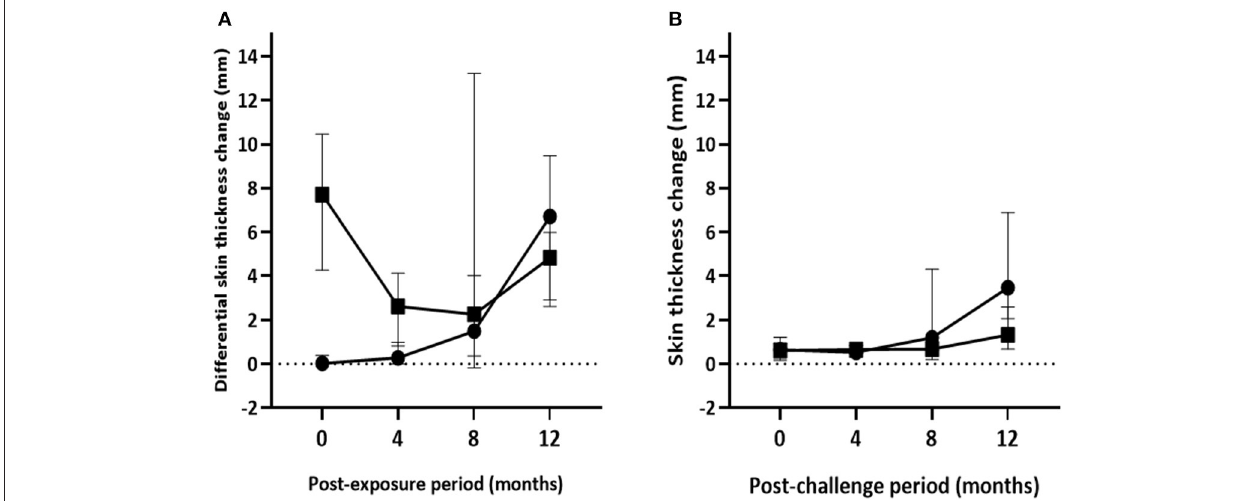
FIGURE 5 | Post-exposure skin test responses in the experimental calves. The figure presents kinetics of skin reactions (in mm) to the PPD (B-A) (A) and the DIVA proteins cocktail (B) injections in the vaccinated and control calves during 12 months of exposure. Solid circle and solid square represent the median ( ± 95%CI) in the control and vaccinated calves at each time point,